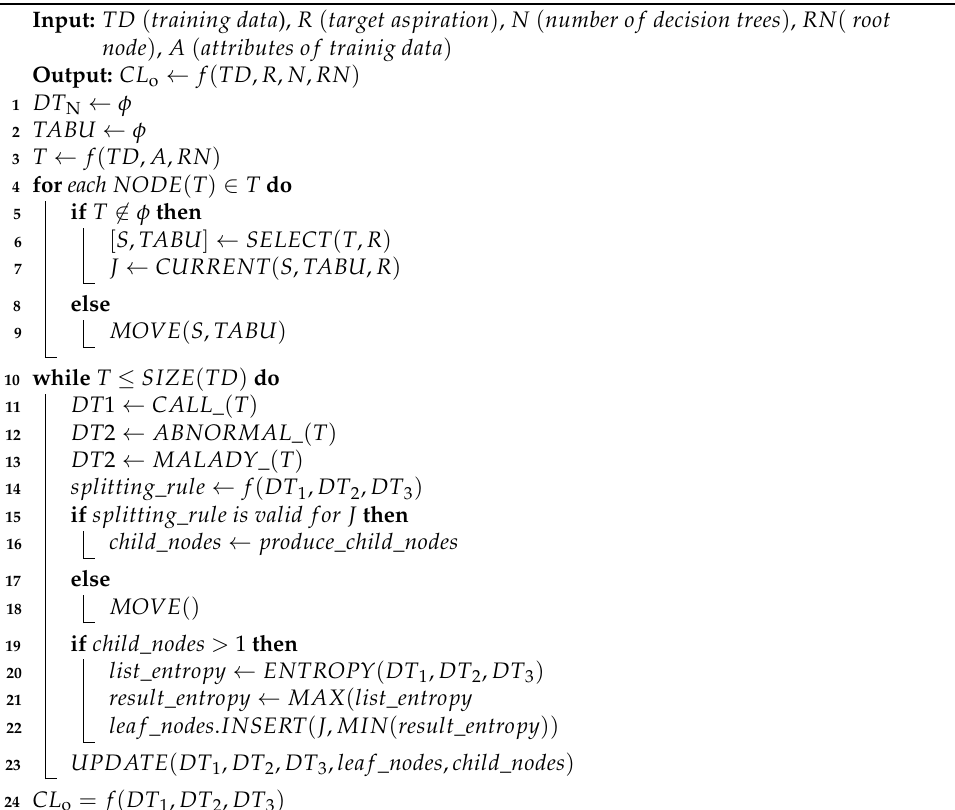
Algorithm 1: Proposed Tabu Search Oriented Decision Tree (TSODT)